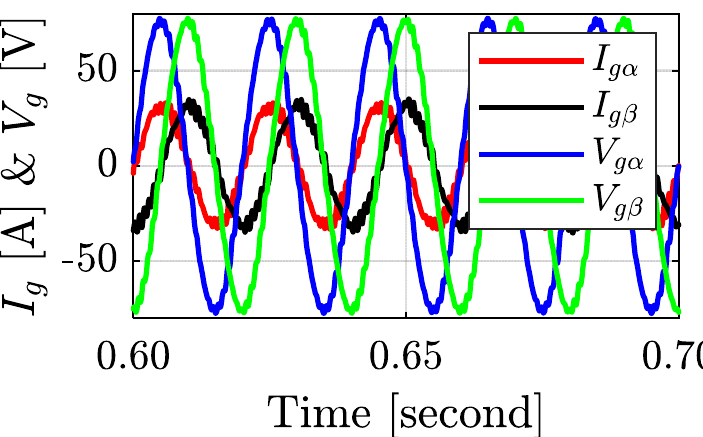
Figure 9. Grid-current spectrum for the: ( a ) conventional PI current controller with SVPWM modulation, and ( b ) proposed MFPC controller (at 100% irradiation level).